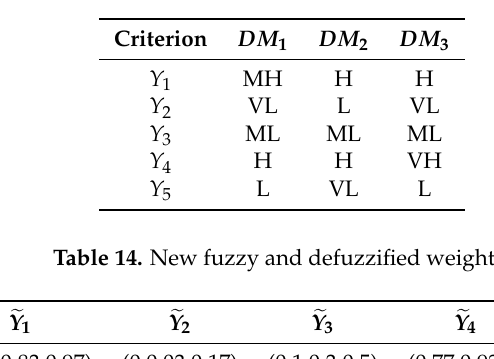
Table 13. New criteria weightage by decision makers.